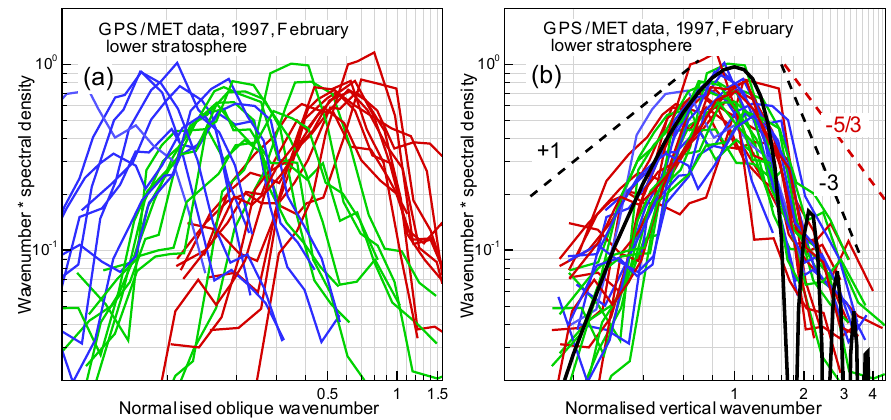
Figure 2. Amplitude fluctuation spectra for the lower stratosphere: (a) spectra as functions of the oblique wave number corresponding to the isotropy hypothesis (Kolmogorov turbulence); (b) spectra as functions of the vertical wave number corresponding to the anisotropy hypothesis (saturated IGWs). The color map red–green–blue corresponds to the increasing obliquity angles, which are subdivided into three groups. The black solid line in panel (b) presents the theoretical vertical spectrum for the saturated IGW model; the dashed lines present the asymptotics of this spectrum for low and high frequencies. The low-frequency asymptotic is evaluated for L W → ∞ . For the comparison, red dashed lines show the high-frequency spectral asymptotic of the Kolmogorov turbulence model.